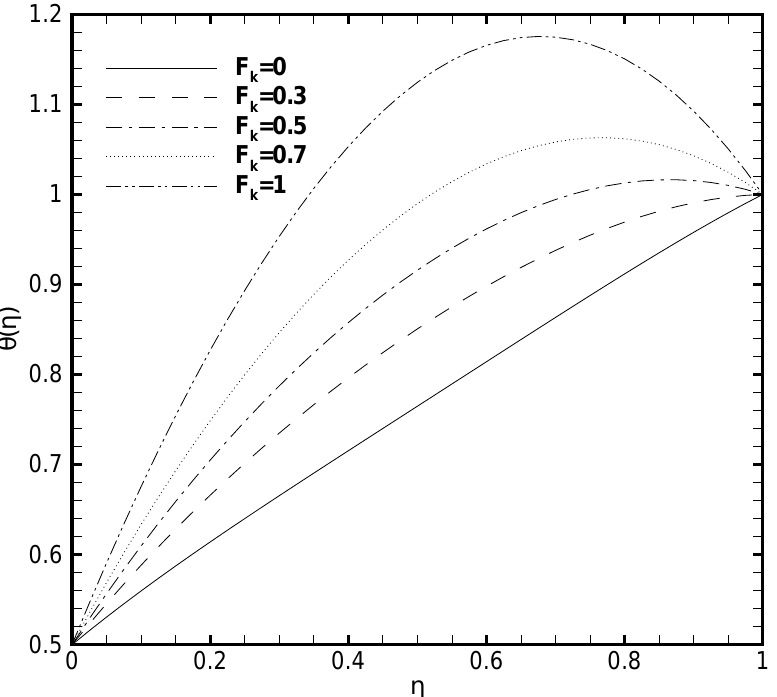
Figure 7. Temperature profile θ ( η ) for several values of Frank-Kamenetskii number F k when ζ = P = κ = Ha = Br = δ θ 2 = 1, N b = 0.2, N t = 0.1, β = 0.05 and δ θ 1 =